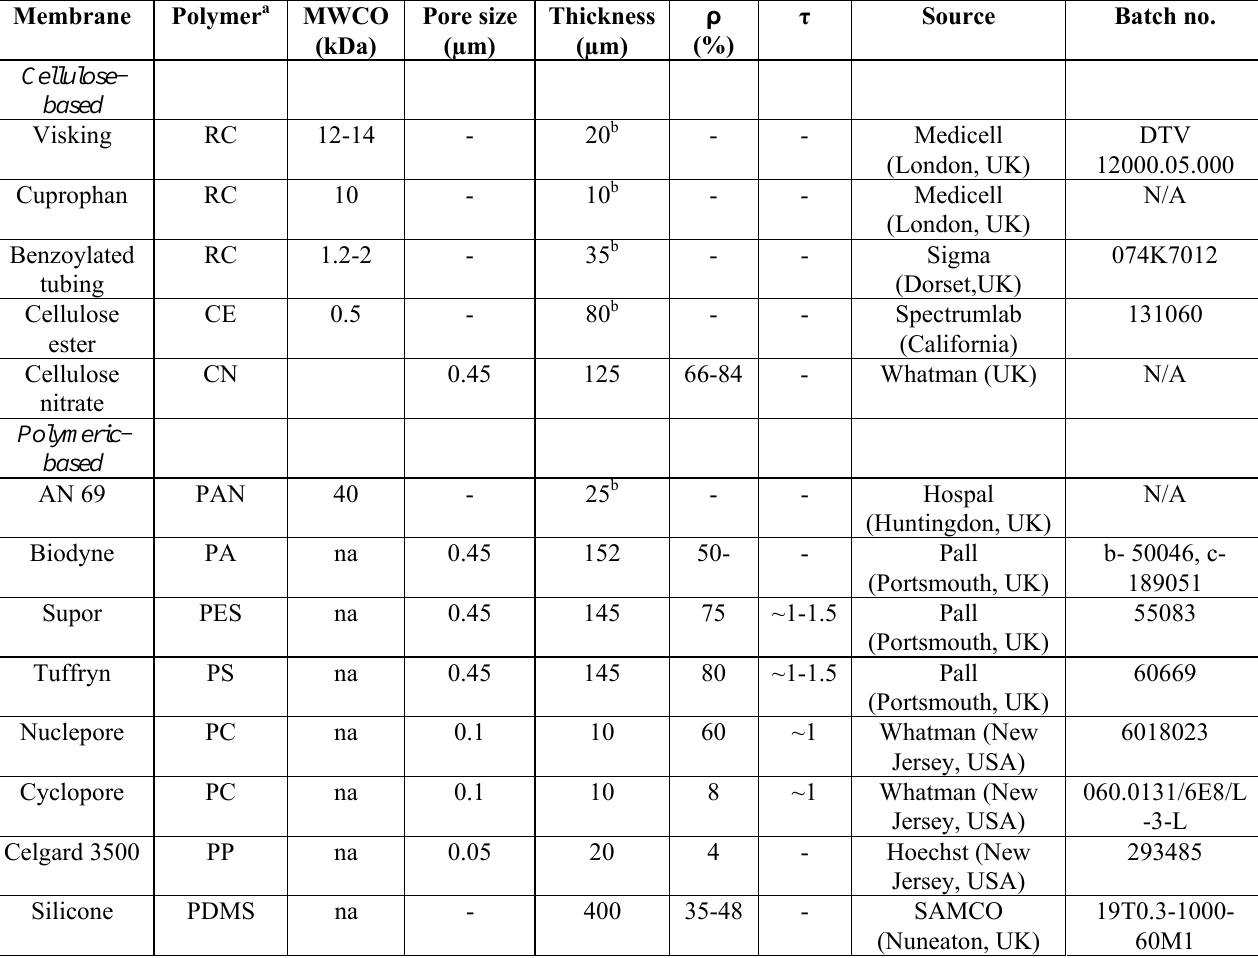
Table 1. Summary of the synthetic membrane properties. All values are nominal provided by manufacturers ( ρ - membrane porosity, τ – membrane